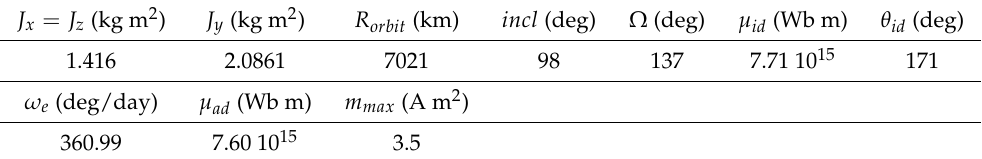
Table 2. Spacecraft, orbit, and geomagnetic field data.